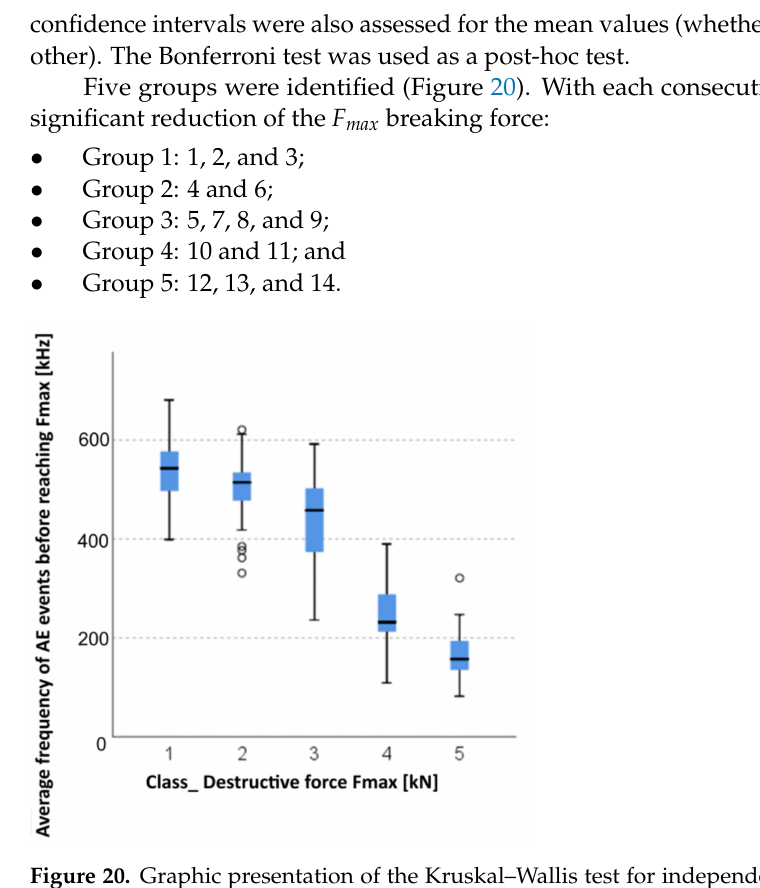
Figure 20. Graphic presentation of the Kruskal–Wallis test for independent samples: average fre- quency of AE events before reaching F max and the breaking force F max